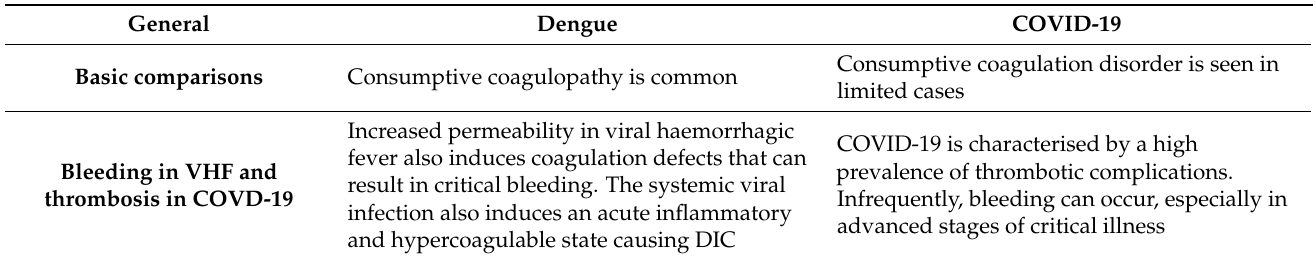
Table 3. Coagulation disorders in COVID-19 and dengue (based on Iba et al. [67]).